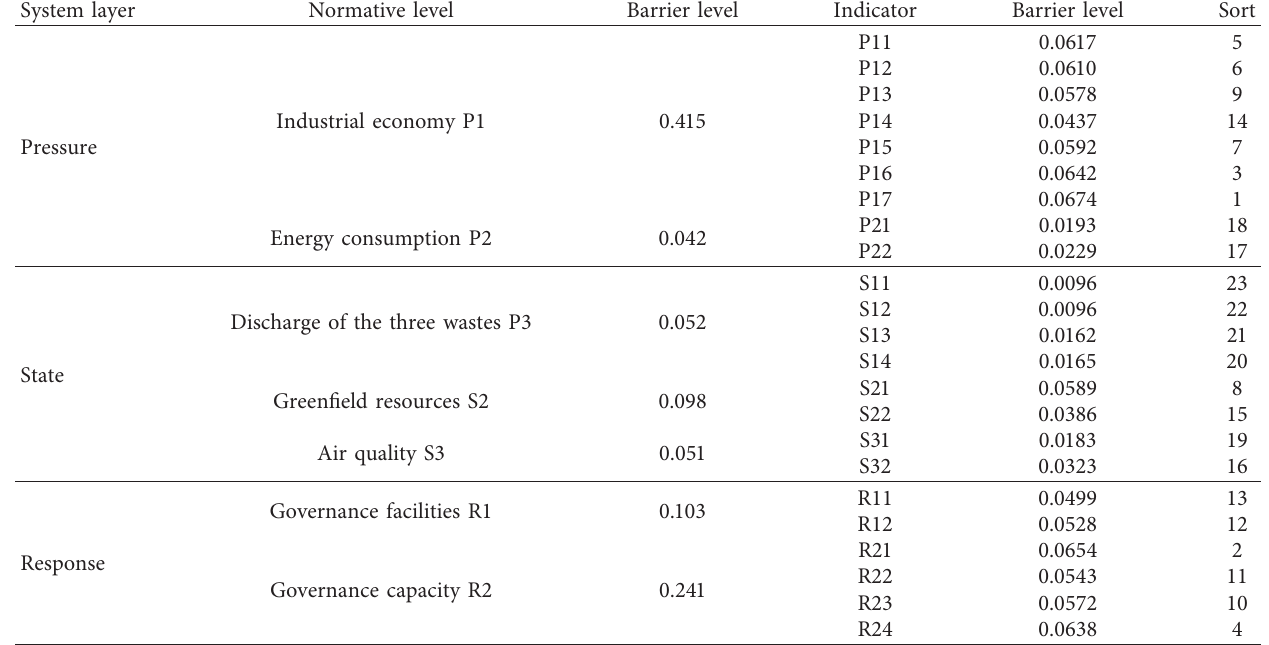
Table 2: Measurements of constraint grade based on PSR model.